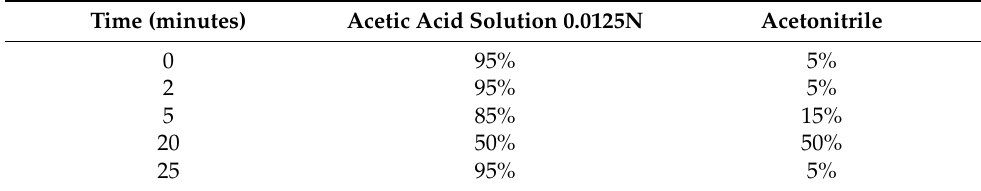
Table 5. Elution gradient for ricinine